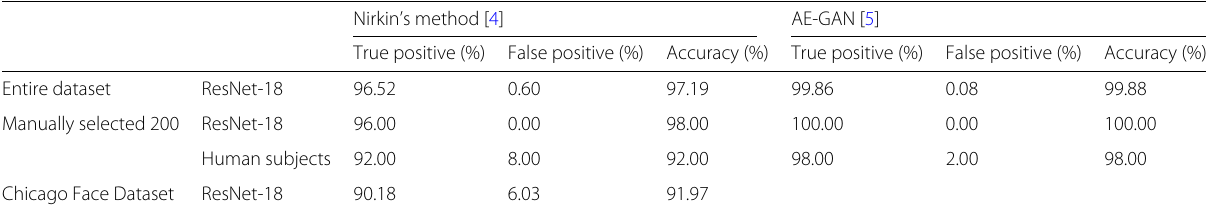
Table 2 Overall